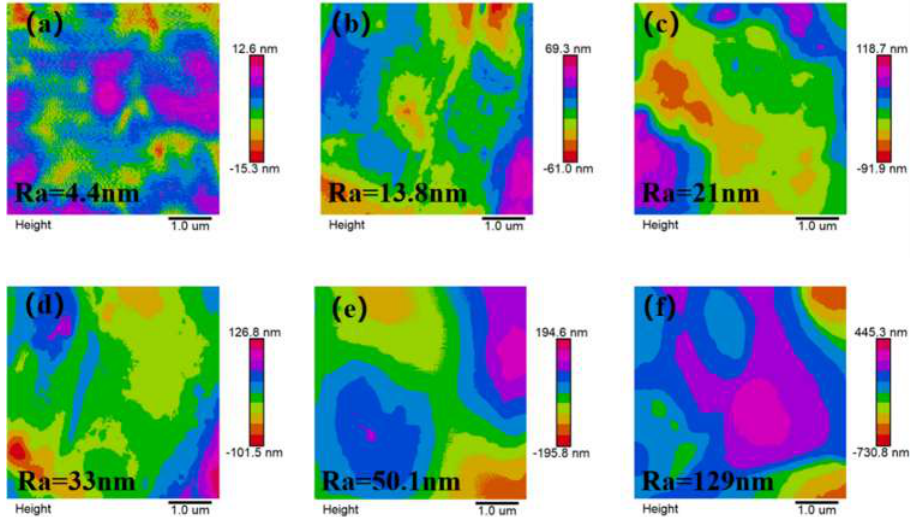
Figure 4. Surface roughness of blend films with different mass fraction ( a ) 0 wt.% PS, ( b ) 1 wt.% 40 nm PS, ( c ) 3 wt.% 40 nm PS, ( d ) 5 wt.% 40 nm PS, ( e ) 5 wt.% 80 nm PS, ( f ) 5 wt.% 120 nm PS.